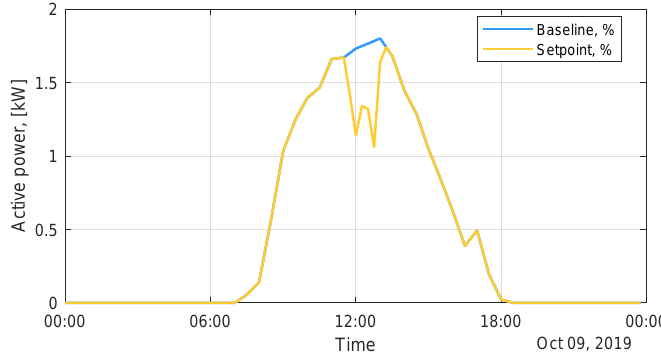
Figure 22. Control action. Generator connected to node 19.